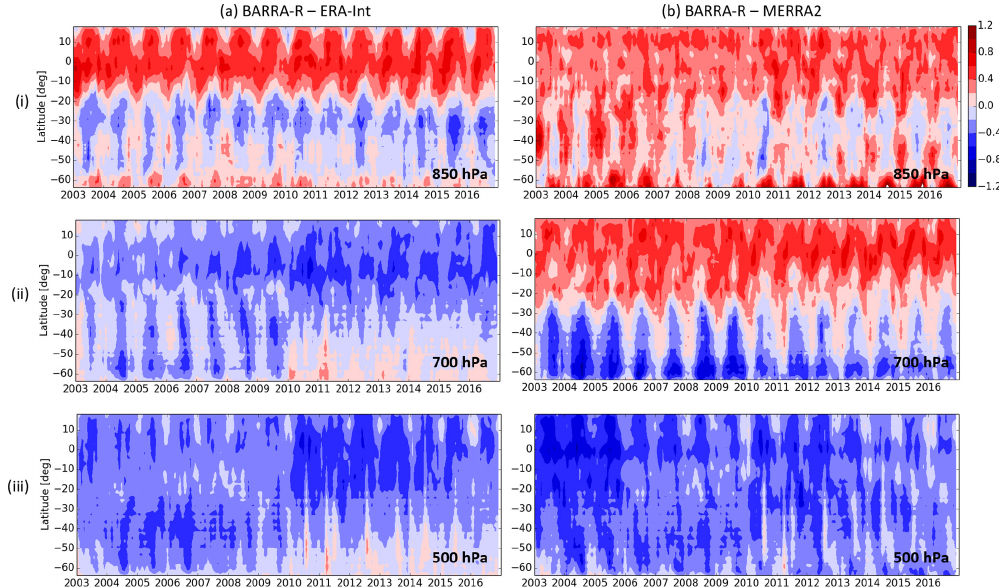
Figure 8. Hovmöller plots of the monthly difference in zonal mean air temperature (K) at 00:00UTC and three pressure levels, (row i) 850, (ii) 700, and (iii) 500hPa, between (a) BARRA-R and ERA-Interim and between (b) BARRA-R and MERRA-2.